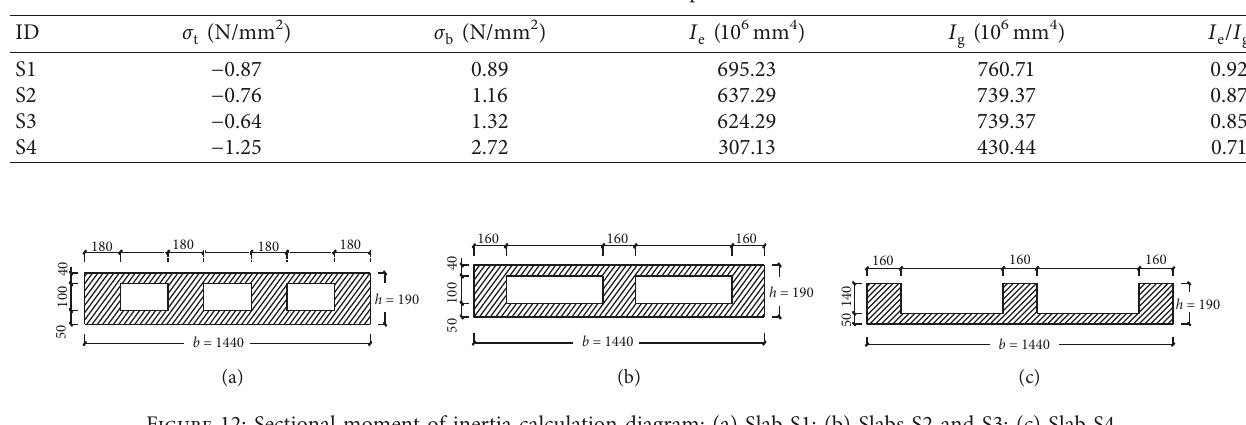
Figure 11: Load-slip curves of the slab end: (a) Slab S1; (b) Slab S2; (c) Slab S3; and (d) Slab S4. Table 6: Amount of composite action.